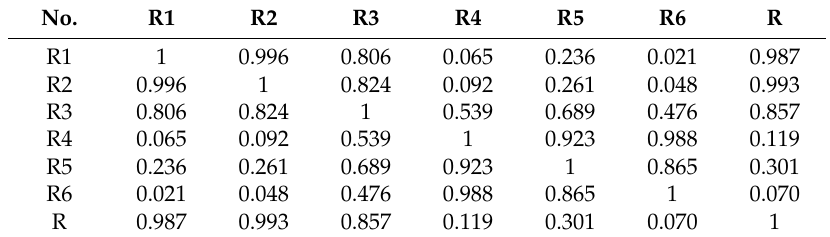
Table 1. The Similarity analysis results of six different parts extracts from cultivated C. deserticola .